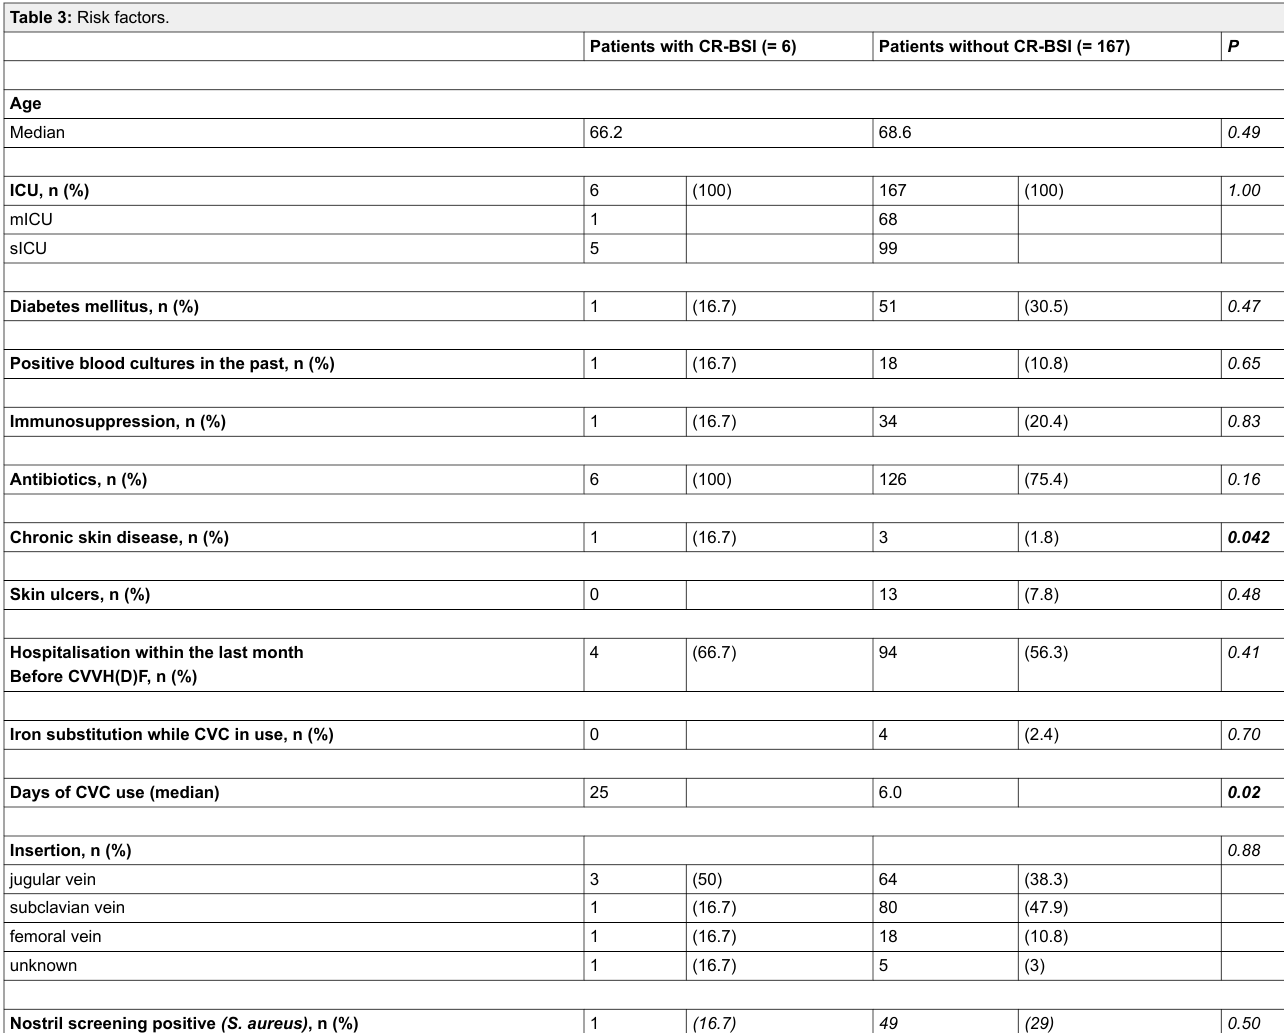
Patients with CR-BSI (=